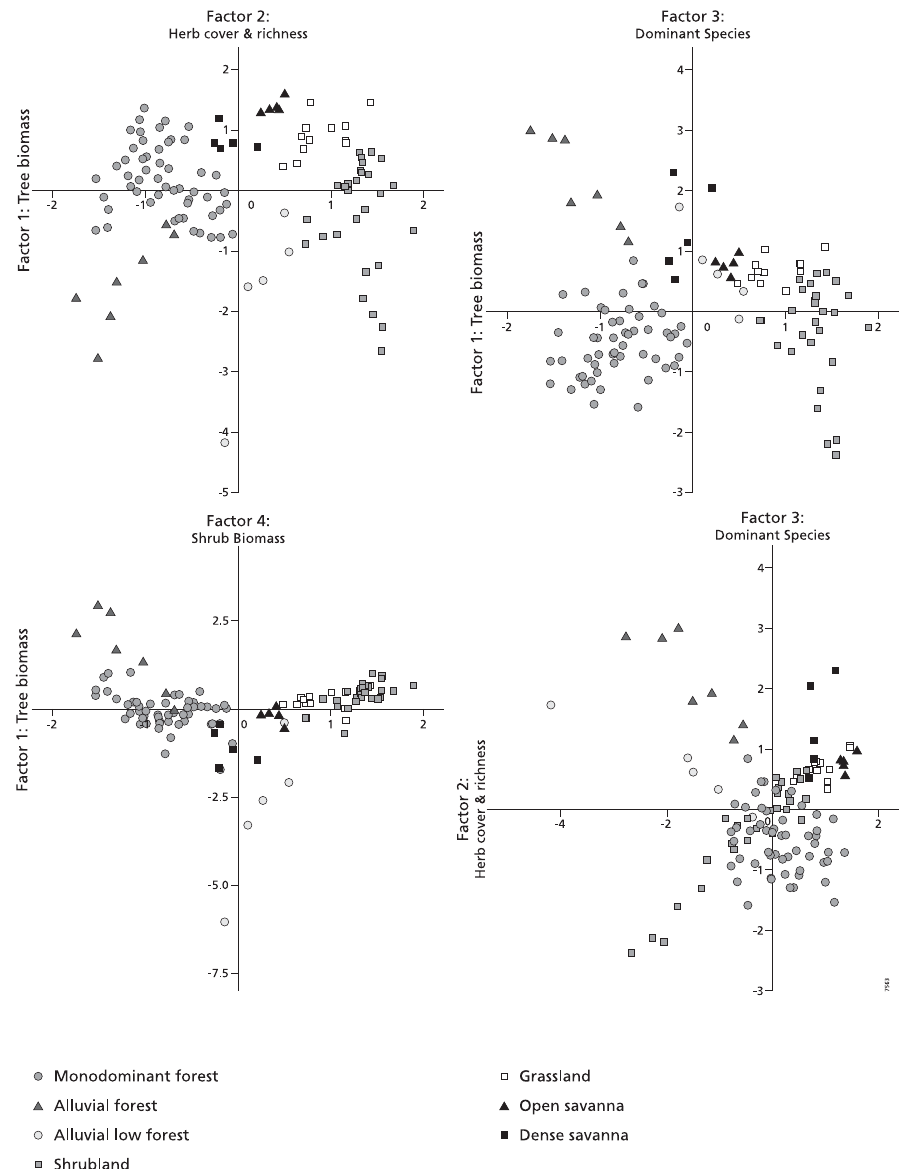
Fig. 4. Factor analysis biplots of the axes 1 to 4 on vegetation variables obtained from 115 sampling locations. Seven clusters (symbols) represent the vegetation communities found in the studied floodplain. Factor 1 describes the gradient of tree biomass found in the study site; Factor 2 of herb cover and richness; Factor 3 of tree dominant species; and Factor 4 of shrub